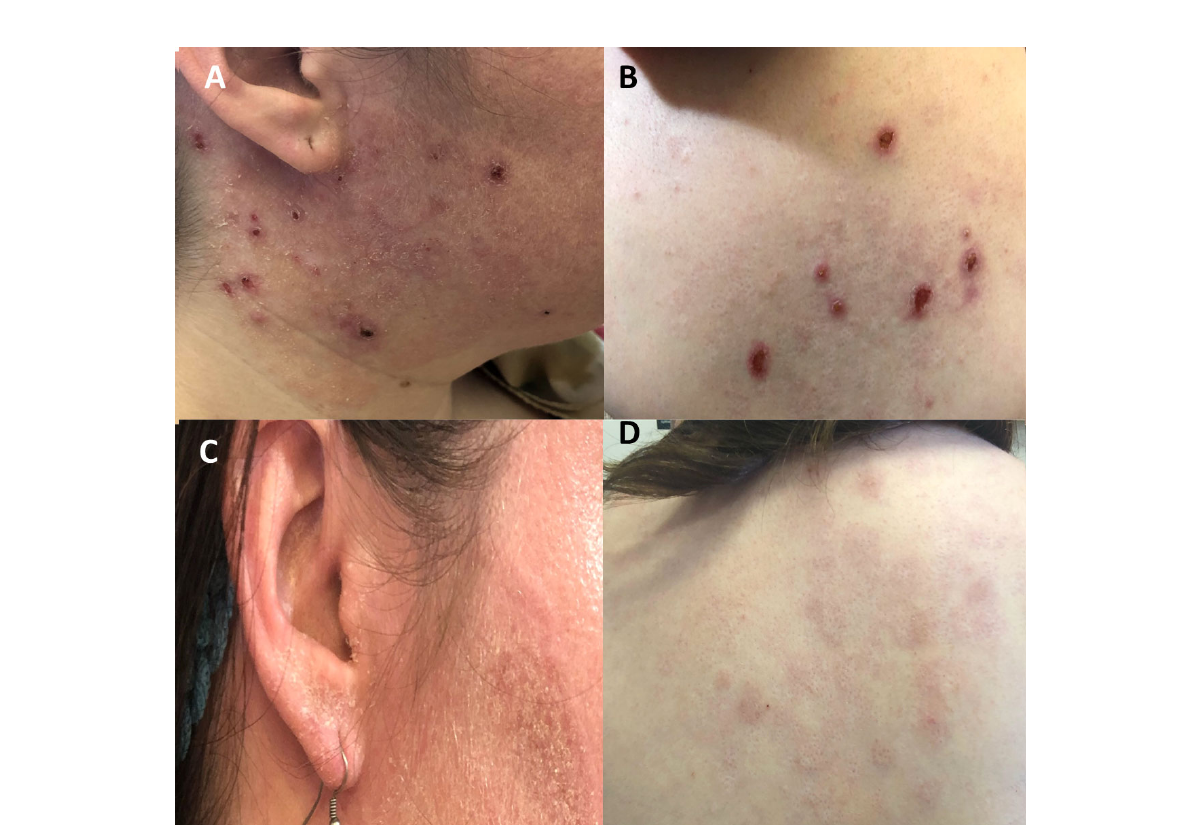
FIGURE 3 Response to treatment with dupilumab in patients with DN- STAT3 variants. (A, B) Baseline status of atopic dermatitis in P2 with multiple erosive nodules, consistent with prurigo nodularis (C, D) Following 3 months of dupilumab treatment, atopic dermatitis eczema has completely